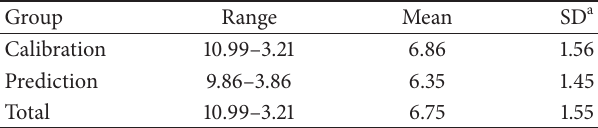
Table 1: Summary of the measured TSS in samples of calibration and prediction set ( ∘